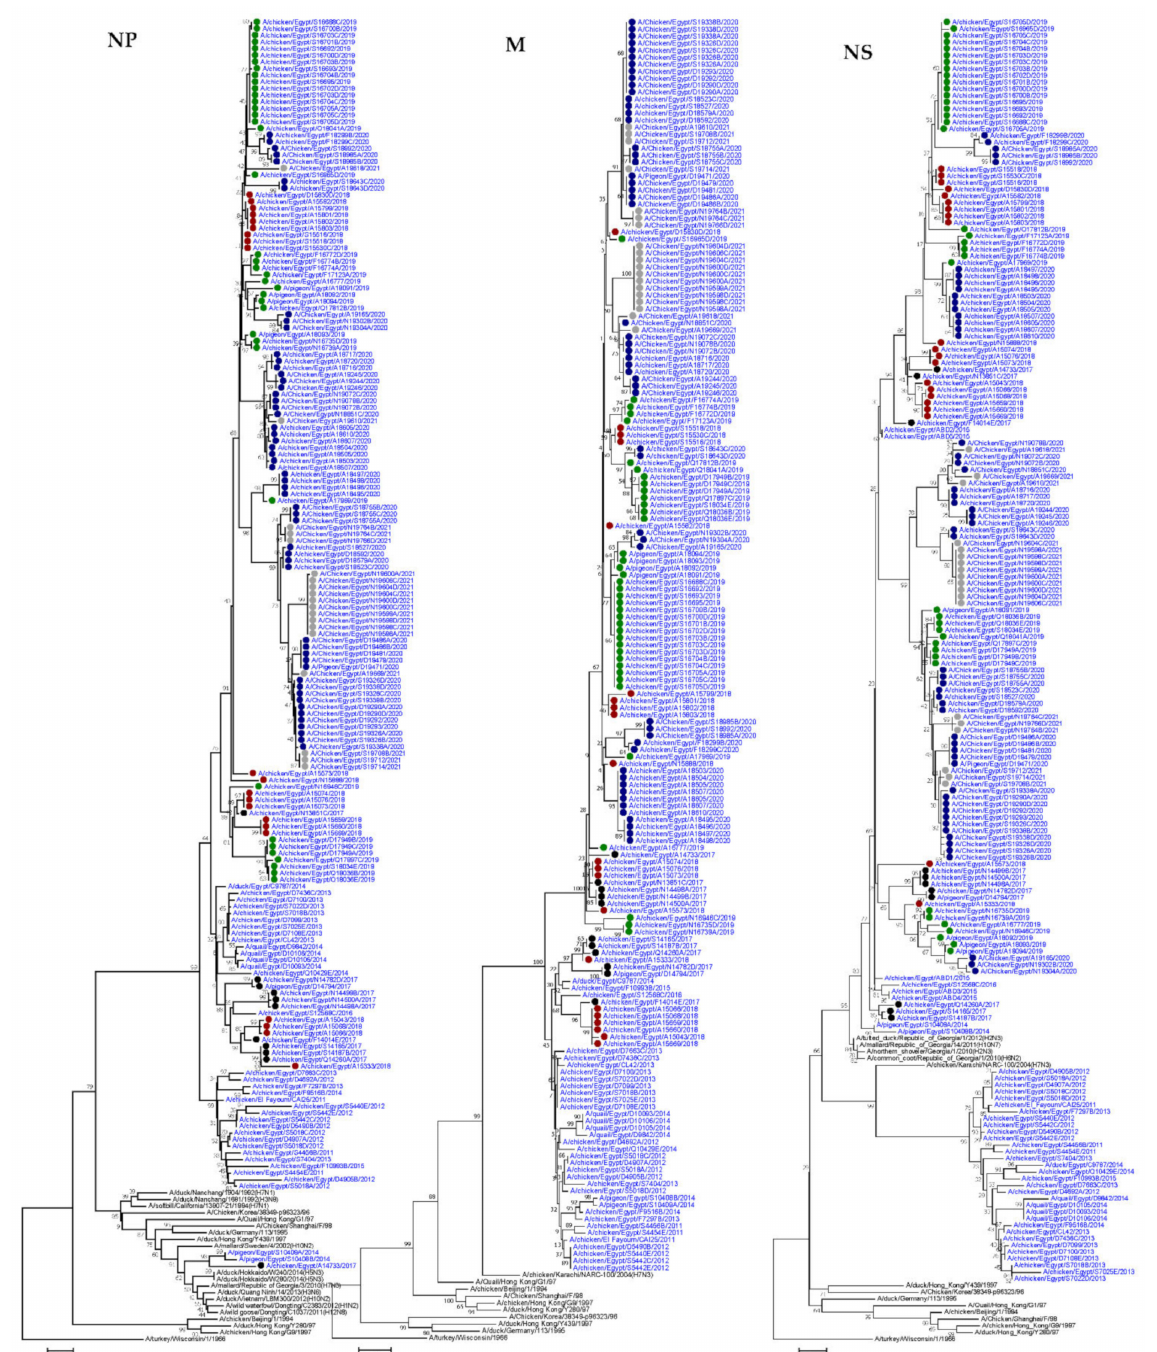
Figure 1. Neighbor joining phylogenetic trees of the six internal segments of the H9N2 viruses detected in Egypt. All Egyptian H9N2 taxa are colored blue and H9N2 viruses sequenced specifically for this study are labeled with colored circles (2017 black, 2018 red, 2019 green, 2020 blue, and 2021 gray). The phylogenetic analysis was performed using MEGA7, and evolutionary distances were computed using the Kimura 2-parameter